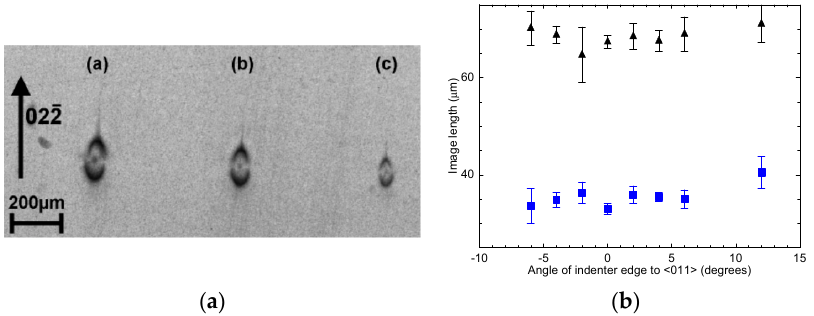
Figure 2. ( a ) X-ray diffraction image taken in white beam mode of 600 mN indents with the indenter tip rotated by 6° with respect to the [011] direction. ( b ) Extent of the X-ray diffraction contrast for 100 mN indents as a function of rotation of the Berkovich tip apex from the [011] direction. Triangles represent image extent in the direction parallel to the diffraction vector, while squares represent the extent perpendicular to the diffraction vector.